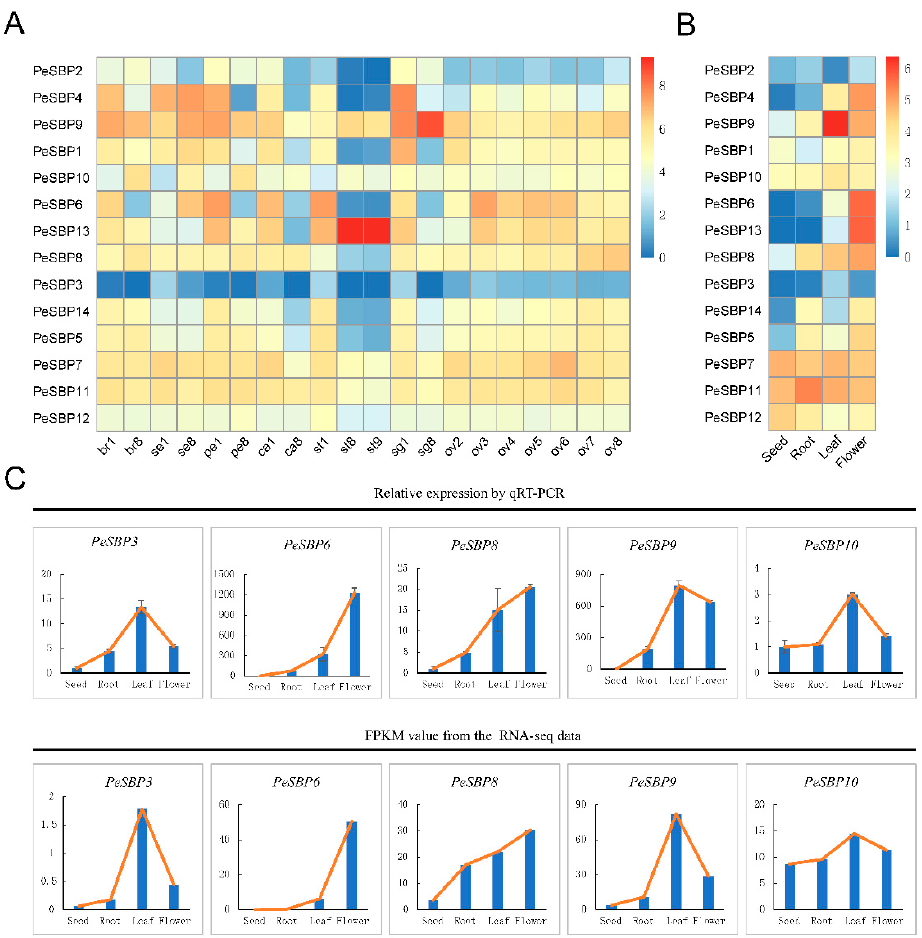
Figure 7. The expression pattern and qRT-PCR results of SBP genes in passion fruit. ( A ) Expression patterns of SBP genes in different tissues and different development stages based on the transcriptome data. br, bract; se, sepal; pe, petal; ca, corona filament; st, stamen; sg, stigma; and ov, ovule. The number represents different stages: 1 and 2 represent early stage, while 7 and 8 represent late stage. ( B ) Expression patterns of SBP genes in different tissues in the seed, root, leaf, and flower. The red color bar indicates high expression patterns, and the blue color bar indicates low expression. ( C ) Validation of 5 randomly selected PeSBP genes by qRT-PCR. The yellow line indicates the expression trend in four tissues.